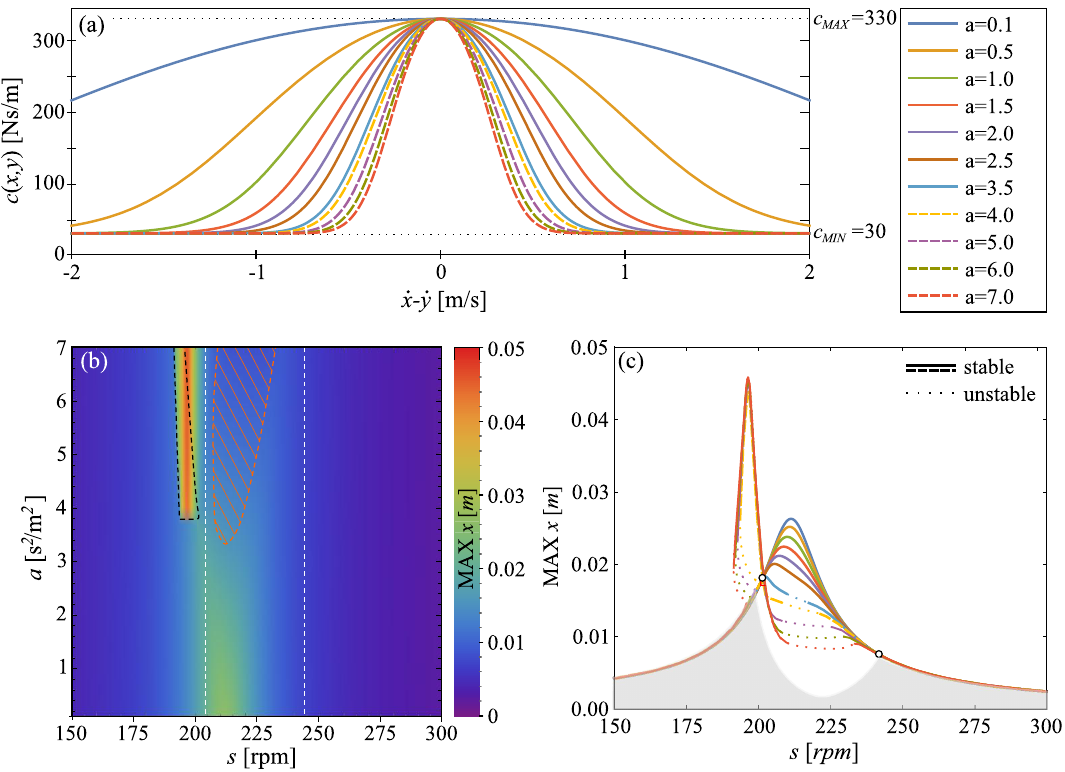
Figure 6. In panel ( a ) we show the damping functions c ( ˙ x , ˙ y ) (Equation (6)) for selected values of a . In panel ( b ) we show two dimensional plot of maximum amplitude of damped system (max x [ m ] ) in two parameters of space: a and s . The last panel ( c ) shows eleven exemplary FRCs of damped